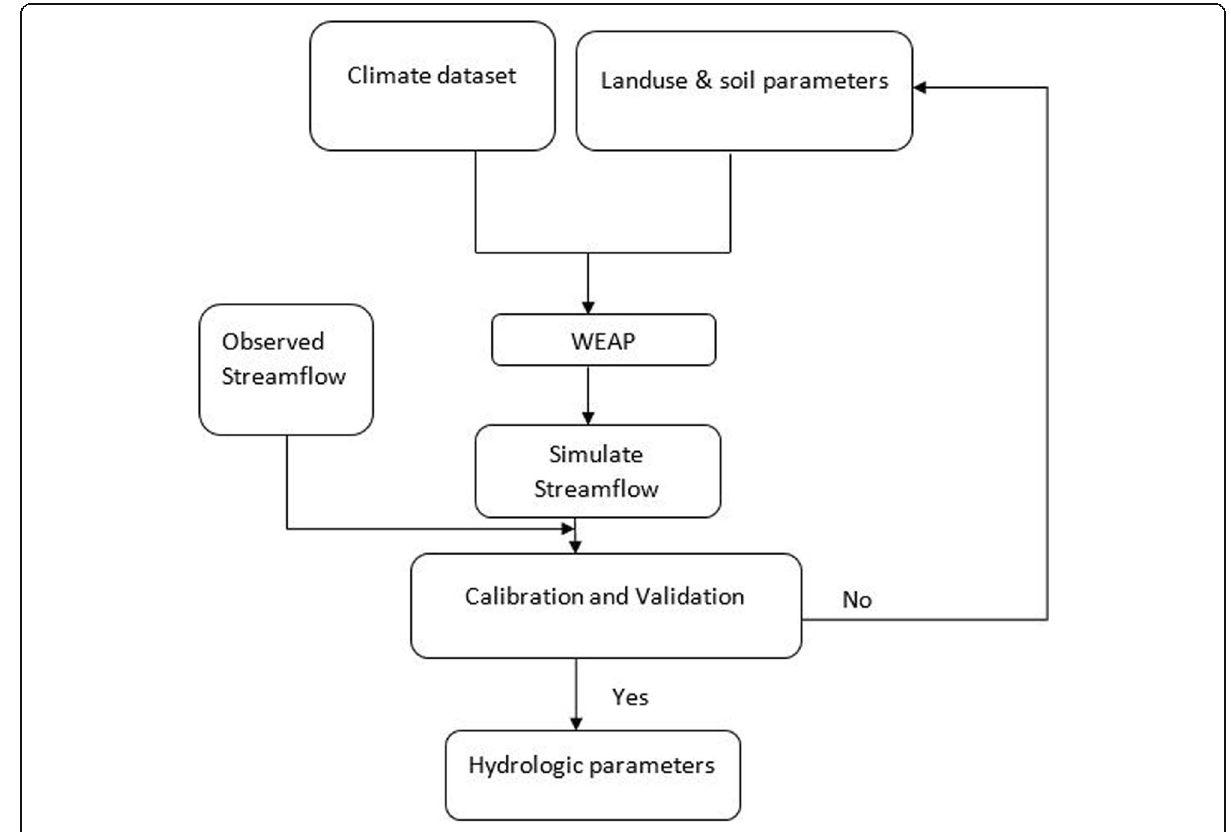
Fig. 5 The schematic diagram for WEAP hydrologic model procedure